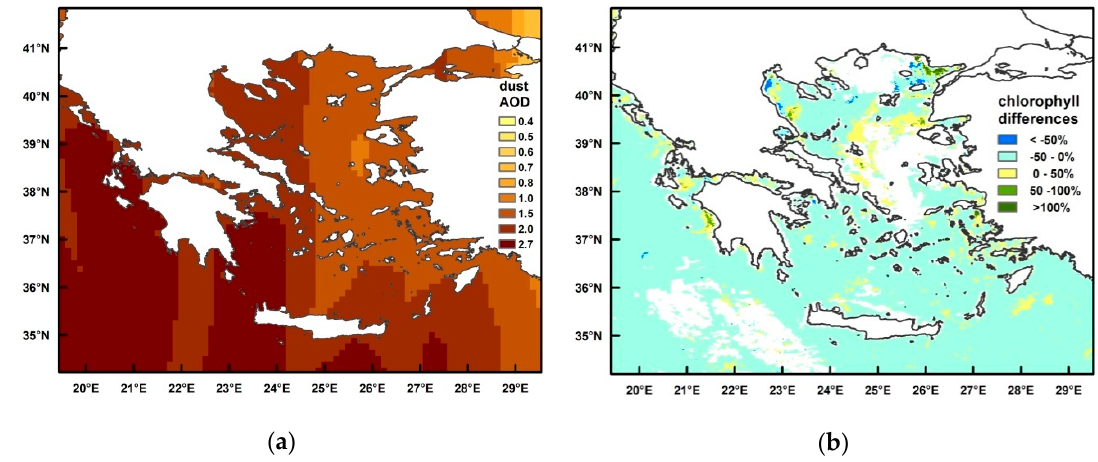
Figure 3. ( a ) Maximum dust AOD during the episode 22-24 March 2016; ( b ) Chl-a % differences between the weeks before (13–20 March 2016) and after (29 March–5 April 2016) the event.